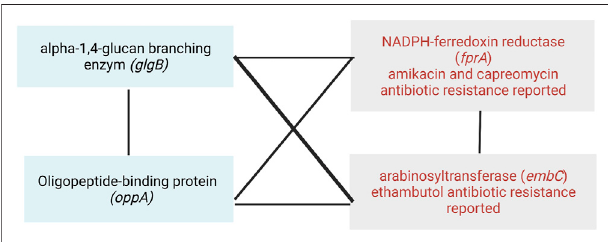
FIGURE 8 | Epistatic interactions between the antibiotic-resistant genes fprA and embC , and the putative targets of co-selection genes glgB and oppA .